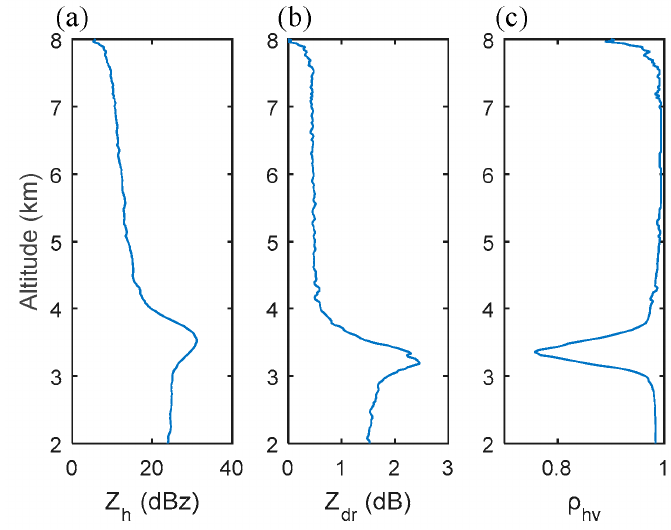
Figure 7. Vertical profile of polarized variables for one stratiform precipitation at 16:25 (BJT) on 4 June 2016. ( a ) Z h ; ( b ) Z dr ; ( c ) ρ hv . Three polarized variables are combined to identify the melting layer and dry snow. The mean Z dr of dry snow for this case is 0.52